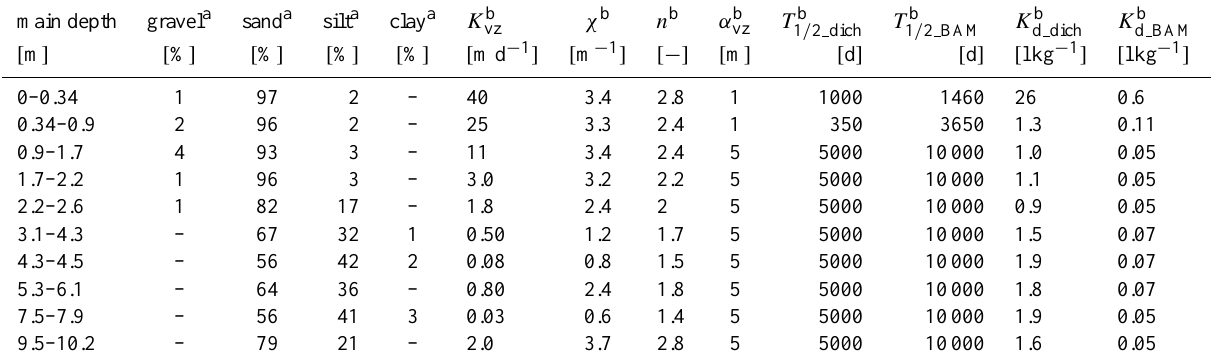
Table 3. Analyzed soil textures (refer to the soil profile sampled in 2003) and model parameters used in the vadose zone model: K sat is saturated hydraulic conductivity, χ is characteristic pore size, n is the tortuousity factor, T 1 / 2 , dich and T 1 / 2 BAM are the half-lives of dichlobenil and BAM, respectively; and K d dich and K d BAM are the sorption coefficients of dichlobenil and BAM,